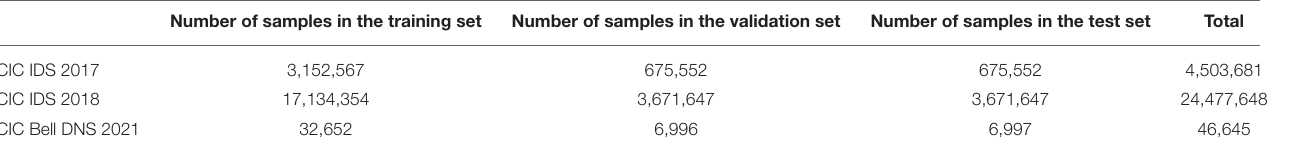
TABLE 6 | Number of samples in training, validation, and testing set for CIC IDS 2017–2018, and CIC Bell DNS 2021 datasets. Number of samples in the training set Number of samples in the validation set